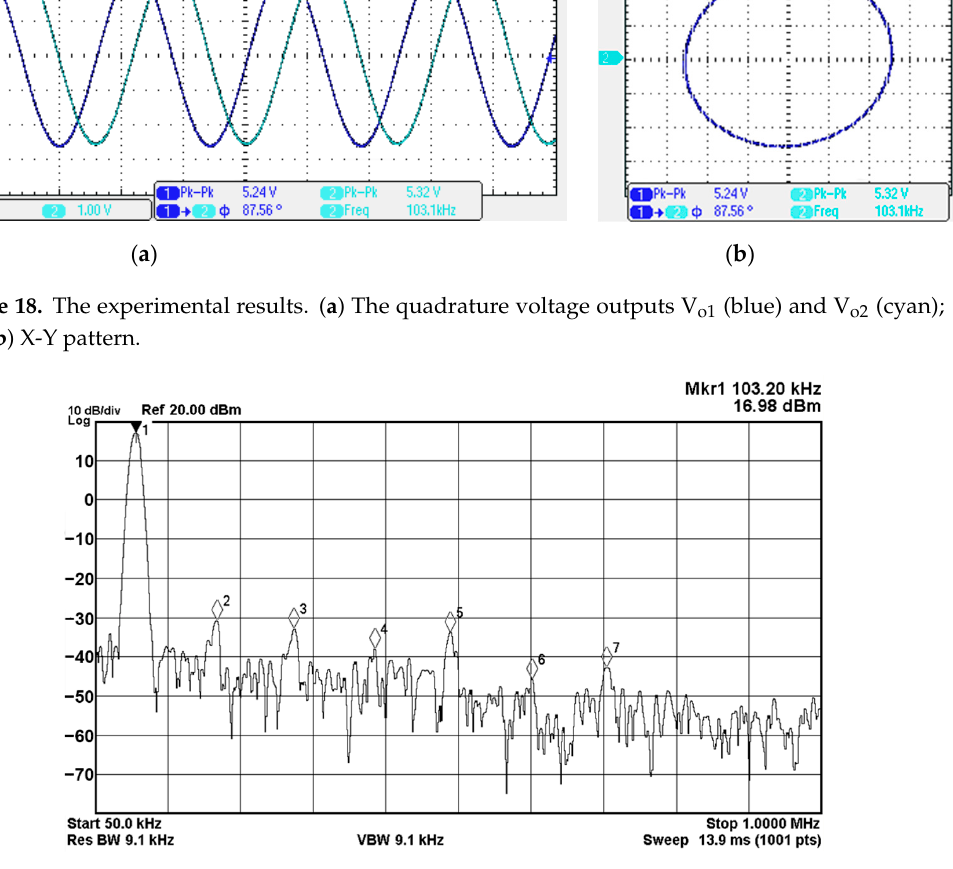
Figure 19. The measured output frequency spectrum of V o1 .